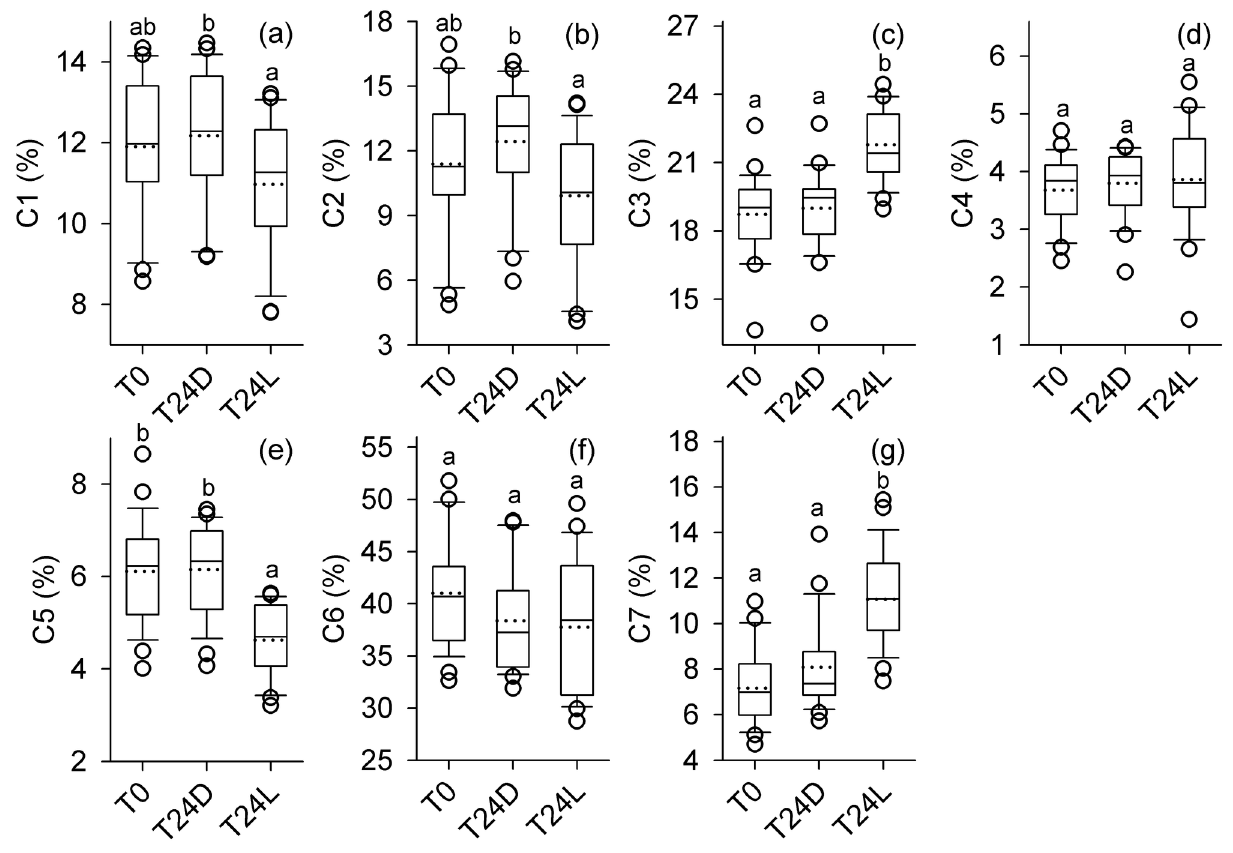
Figure 3. Responses of PARAFAC components (C1-7; %) to photo-irradiation of urban pond DOM. Box plots show the median (solid line), mean (dotted lines), 25 th and 75 th percentiles (boxes), 10 th to 90 th percentiles (whiskers), and >90 th percentiles (dots) prior to photo-irradiation (T0), after dark treatment (T24D), and after light treatment (T24L). Values denoted with different letters are significantly different ( p <0.05).